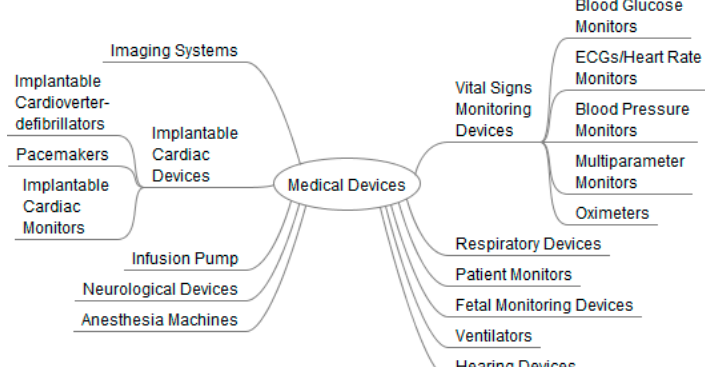
Figure 1. Examples of medical devices.